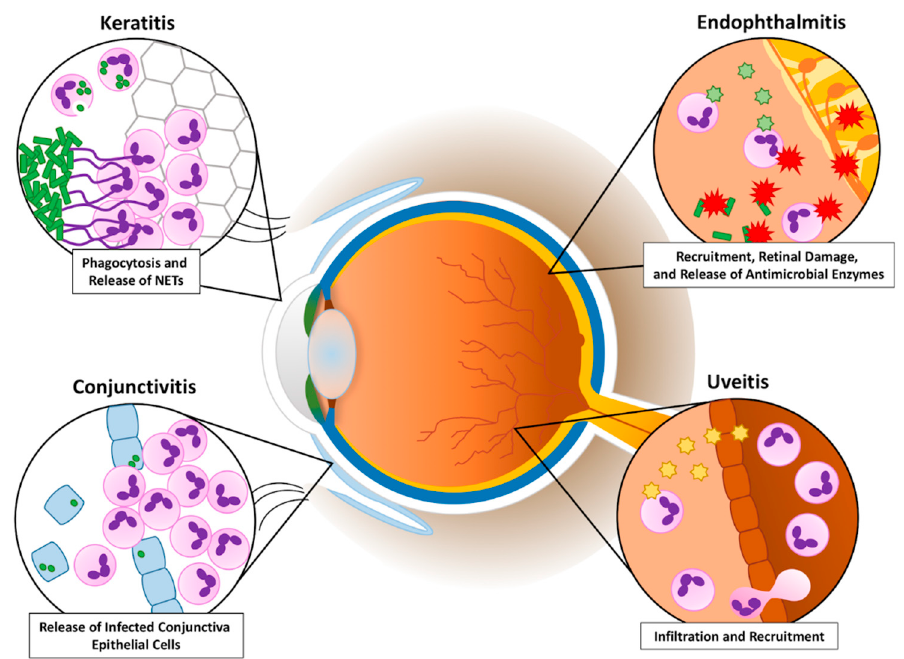
Figure 9. Summary of PMN responses to ocular bacterial infections. This figure illustrates PMN responses that have been observed in the di ff erent areas of the eye during conjunctivitis, keratitis, uveitis, and endophthalmitis. During conjunctivitis, PMNs damage the conjunctival epithelial barrier by accumulating and releasing infected epithelia onto the surface of the conjunctiva. The presence of PMNs during this infection causes a decrease in transforming growth factor-beta (TGF- β ) and interleukin-5 (IL-5), which is suggested to downregulate IgA humoral responses [26,56]. The PMN response during keratitis includes a release of neutrophil extracellular traps (NETs) to prevent the further dissemination of bacteria. PMNs have also been observed to bacteria in the cornea and produce IL-1 β and IL-17 as part of their response [80,83,99,120,183,184]. In some uveitis models, PMNs are recruited quickly into the eye, and self-recruit by producing LTB4 and other proinflammatory molecules [133,142]. PMNs in the endophthalmitis also self-recruit by releasing recruiting chemokines such as TNF- α , but may also cause retinal damage by producing antimicrobial enzymes and reactive oxygen species (ROS)